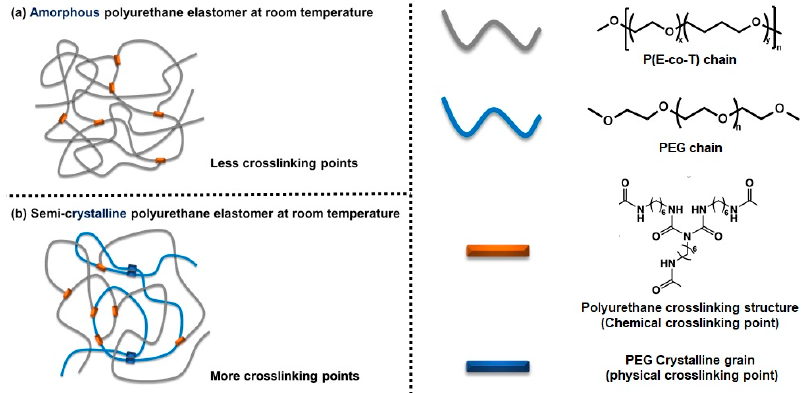
Figure 1. Aggregations of polyurethane crosslinked thermoset elastomers.